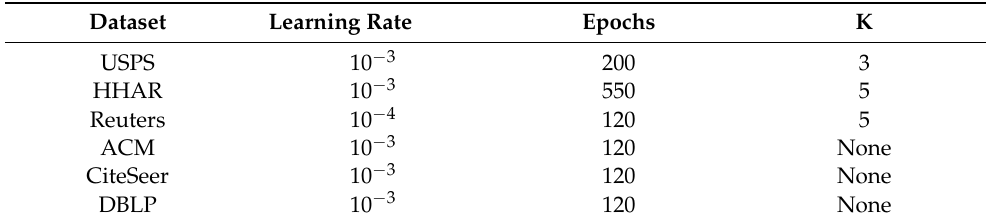
Table 3. Parameter settings used for each training set when training the Quasi-GNN module. K represents constructing a K-nearest neighbor graph for non-graph data, and if the value is none, it means that the original data is graph